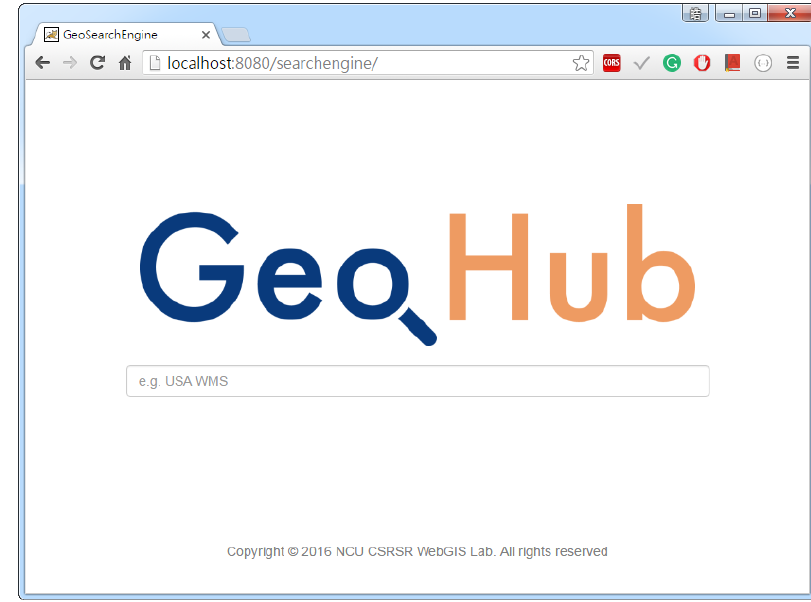
Figure 13. GeoHub client interface.